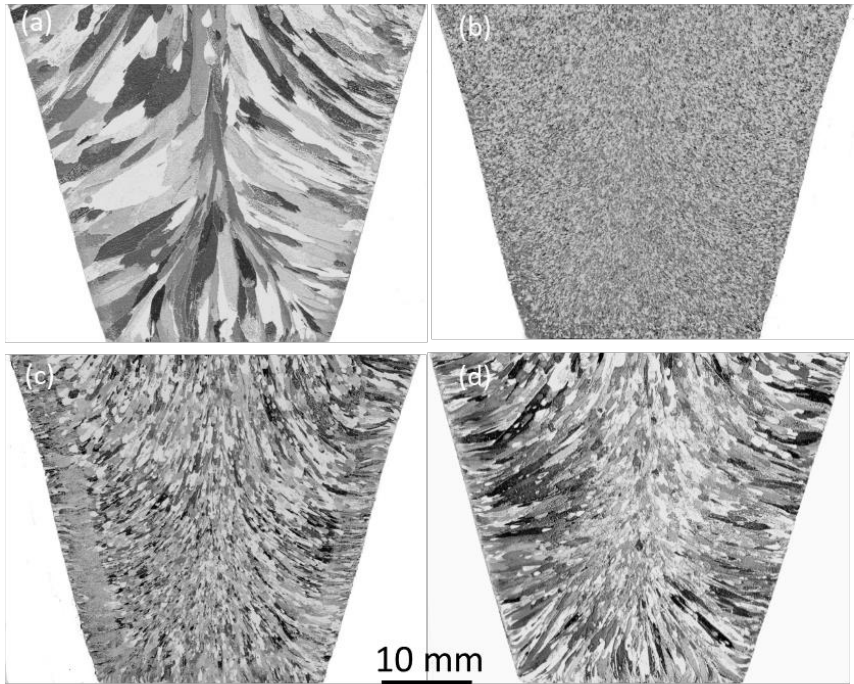
Figure 5. Grain structures of CP-Al solidified in TP-1 mold showing that synthetic TiB 2 particles have no grain refining ability [11]. Macrographs of grain structures at longitudinal sections of CP-Al ( a ) without any addition; ( b ) with addition of 0.2% commercial Al-5Ti-1B grain refiner; ( c ) with addition of synthetic TiB 2 particles; and ( d ) with both synthetic TiB 2 and excess Ti (TiB 2 numbers and excess Ti are equivalent to those of 0.2% Al-5Ti-1B).